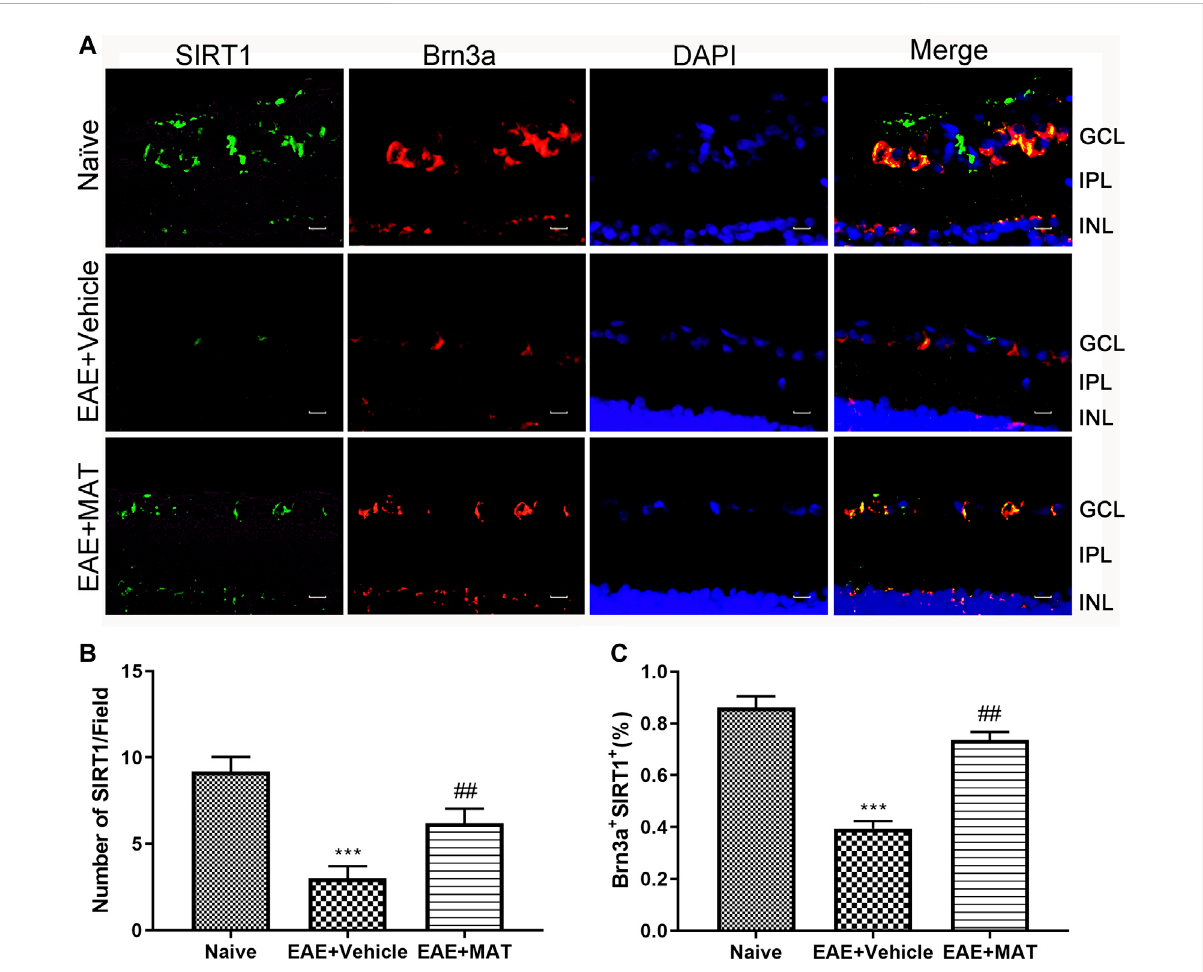
MATpromotedSIRT1expressioninRGCs.Eyeballswereharvestedfromnaiverats,MAT-andvehicle-treatedEAErats. (A) Immuno fl uorescence double staining suggested that SIRT1 (FITC, green) were colocalized with Brn3a (Cy3, red) in the eyeball retina of EAE rats (200×). Scale bars, 10 μ m. (B) Quantitativeanalysisofthenumberofpositivecells. (C) Quantitativeanalysisoftherateofpositivecells.Datarepresentmean±SD;n=10ratsper group. ** p < 0.01, *** p < 0.001, comparison between naive and vehicle-treated EAE groups. ## p < 0.01, comparison between vehicle- and MAT-treated EAE